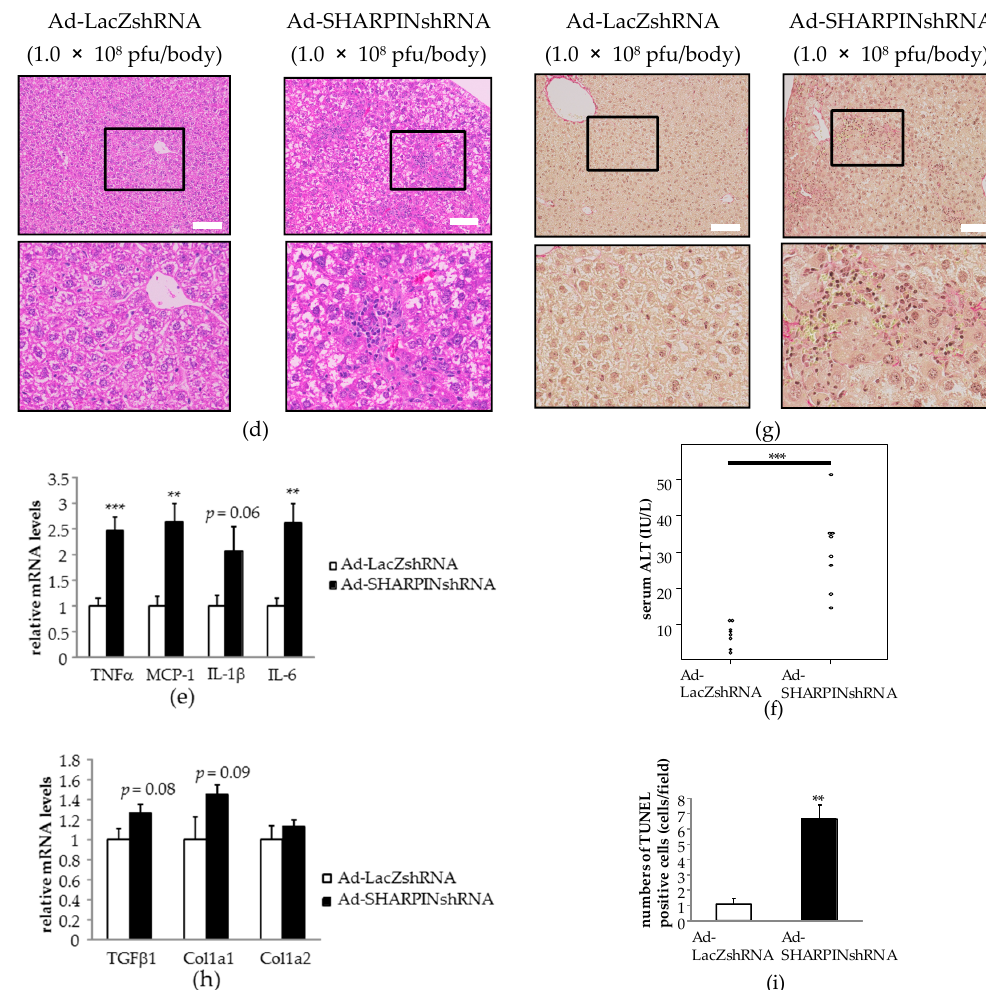
Figure 2. SHARPIN knockdown induces inflammation and fibrosis in the liver accompanied by increased apoptosis. ( a ) Immunoblotting of each LUBAC component in the liver. ( n = 8) (* p < 0.05, ** p < 0.01); ( b ) mRNA levels of each LUBAC component in the liver. ( n = 8) (* p < 0.05, ** p < 0.01); ( c ) Liver lysates were fractionated by gel filtration and then subjected to immunoblotting of each LUBAC component. Arrows: objective bands, asterisks: non-specific bands. P: positive controls (mouse total liver lysate for SHARPIN and lysate from Hepa1-6 cells transfected with mouse HOIL-1L plasmid for HOIL-1L); ( d ) H-E staining of the liver. Lower pictures are the enlarged versions of the framed portions. (Scale bar: 100 µm); ( e ) mRNA levels of inflammatory cytokines in the liver. ( n = 7–8) (** p < 0.01, *** p < 0.001); ( f ) Serum ALT level. ( n = 8) (*** p < 0.001); ( g ) picrosirius red staining of the liver. Lower pictures are the enlarged versions of the framed portions. (Scale bar: 100 µm); ( h ) mRNA levels of profibrogenic cytokines in the liver. ( n = 7–8); ( i ) TUNEL (terminal deoxynucleotidyl transferase (TdT) dUTP nick-end labeling) staining of the liver was performed and TUNEL-positive cells were counted in three randomly selected fields (magnification field 200×) in each mouse. (** p < 0.01). PFU, plaque forming units. n.s., not significant.